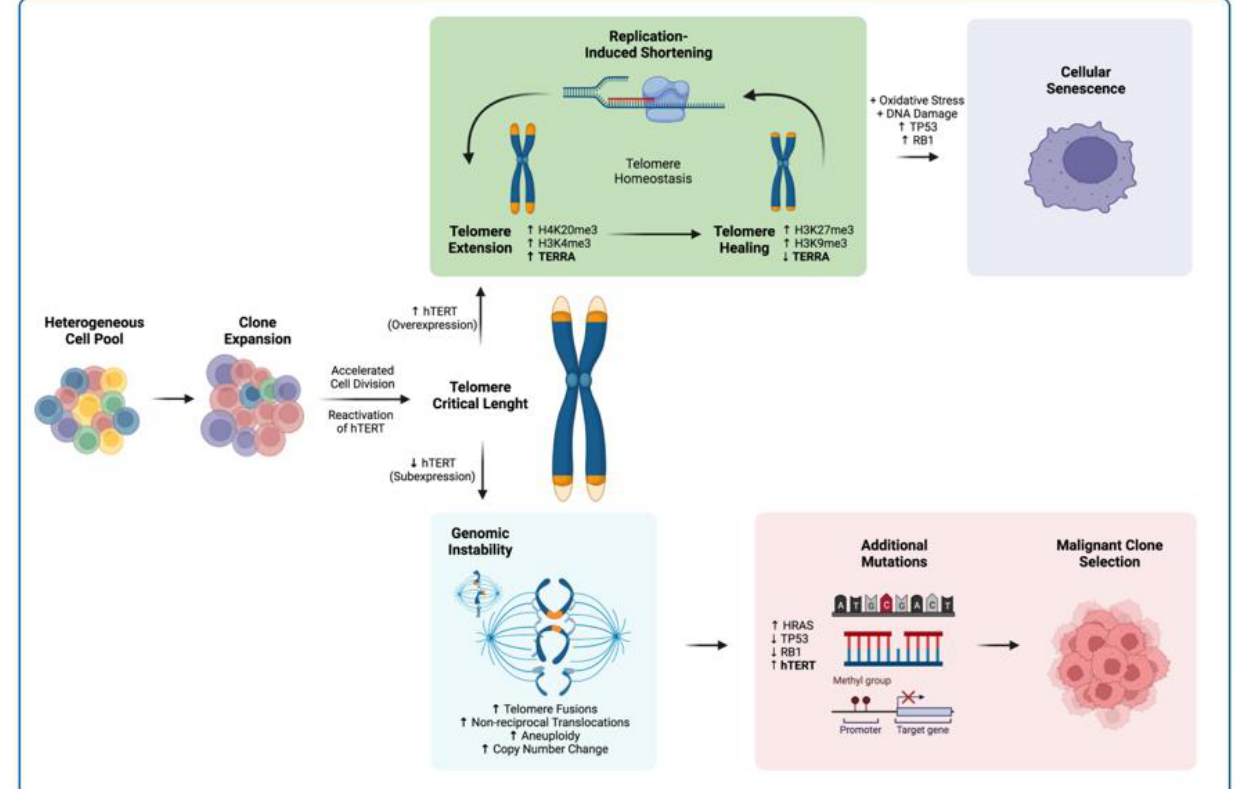
Figure 11. Proposed model for TERRA involvement in telomere recovery. In spite of hTERT reactivation, the expansion of a cell clone leads to critical telomere length due to an accelerated cell division. If hTERT is overexpressed, telomere healing ensues, and homeostasis is recovered. If hTERT expression does not resolve telomere loss, then genomic instability takes place. If the conditions are met, both scenarios can further develop. Upper panel . In cells with stable telomere length, proliferation can still be halted. Accumulation of DNA damage under physiological levels of oxidative stress can lead to the TP53/RB1-mediated cell cycle arrest and the induction of cellular senescence [18,89]. Lower panel . In cells with critical telomere length, further mutations can accumulate due to genomic instability. Mutations in genes such as HRAS, TP53, and RB1, together with the re-expression of hTERT , can prompt a cell towards malignant transformation [86 – 88].